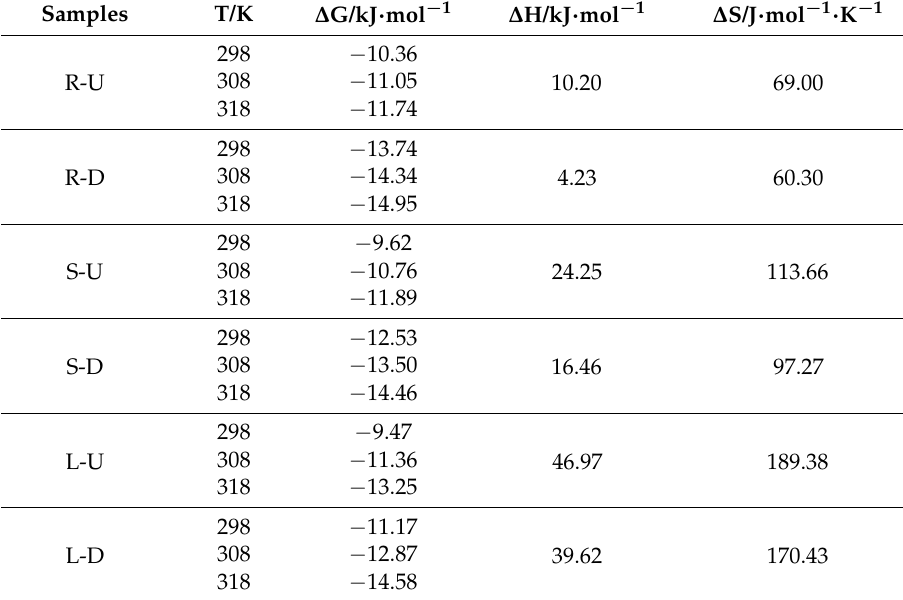
Table 3. Thermodynamics parameters for OTC adsorption onto reed